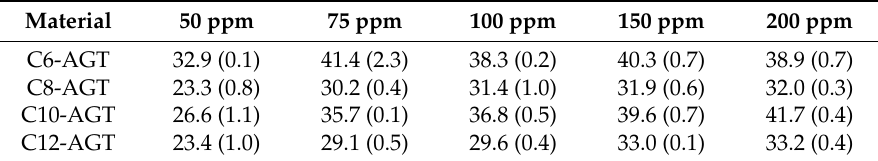
Table 4. Percentages of 2-CP removed using 150 mg of adsorbent at varying concentrations of